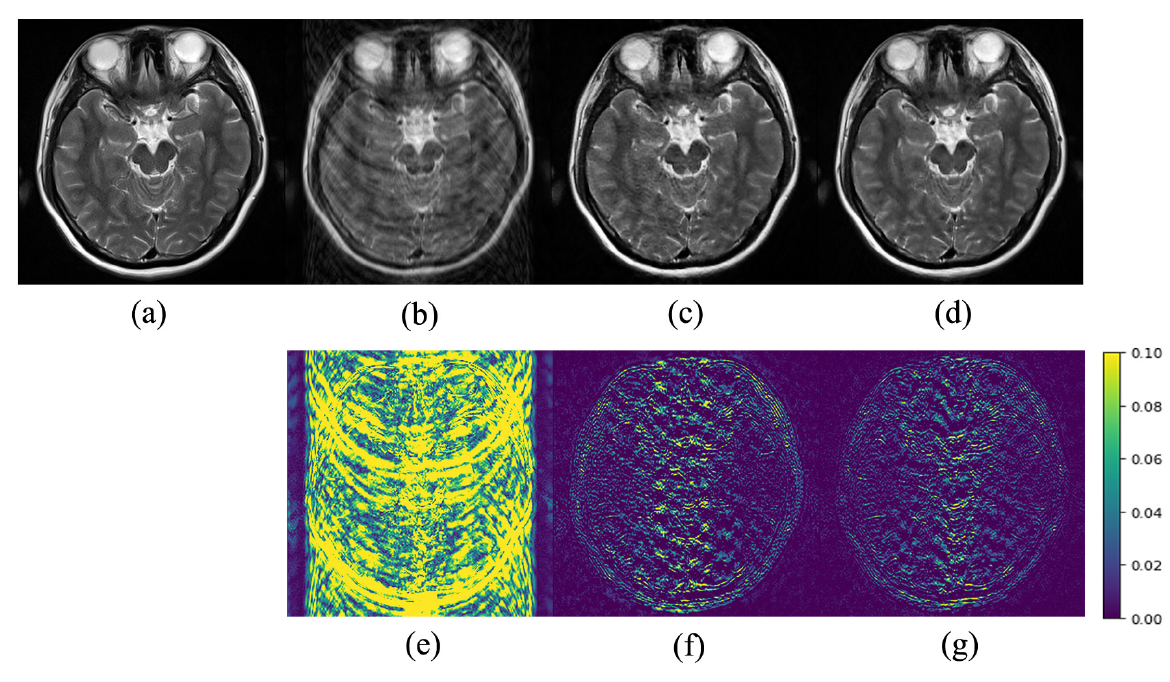
Figure 7. Comparison of the reconstruction results of the target MR image: ( a ) in Brain C using the Cartesian undersampled mask with 30% sampling rate; ( b ) zero-filling reconstruction; ( c ) DIP reconstruction; ( d ) the proposed method reconstruction and corresponding error maps ( e )–( g ).